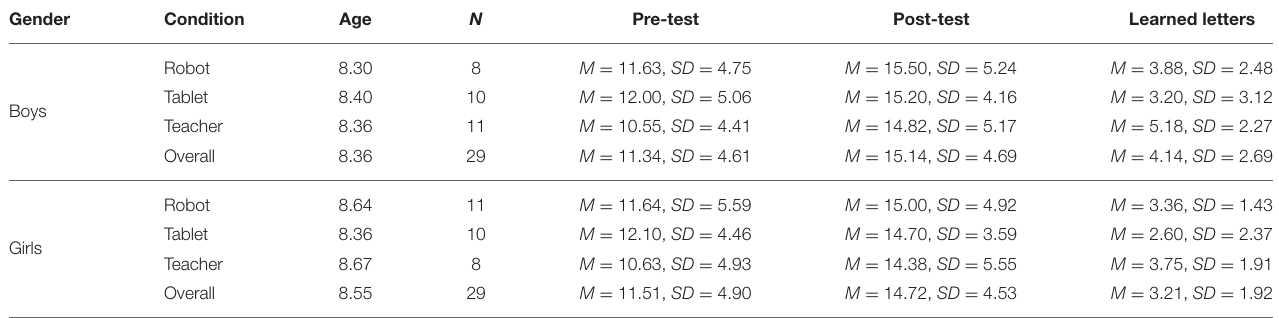
TABLE 1 | Pre- and post-test descriptives.